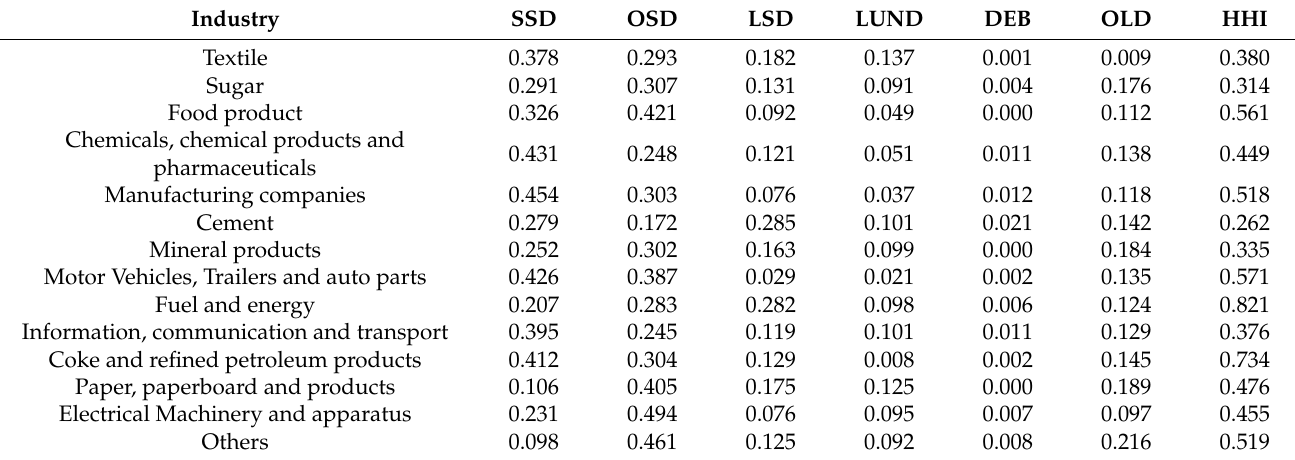
Table 6. Debt types and debt specialization over